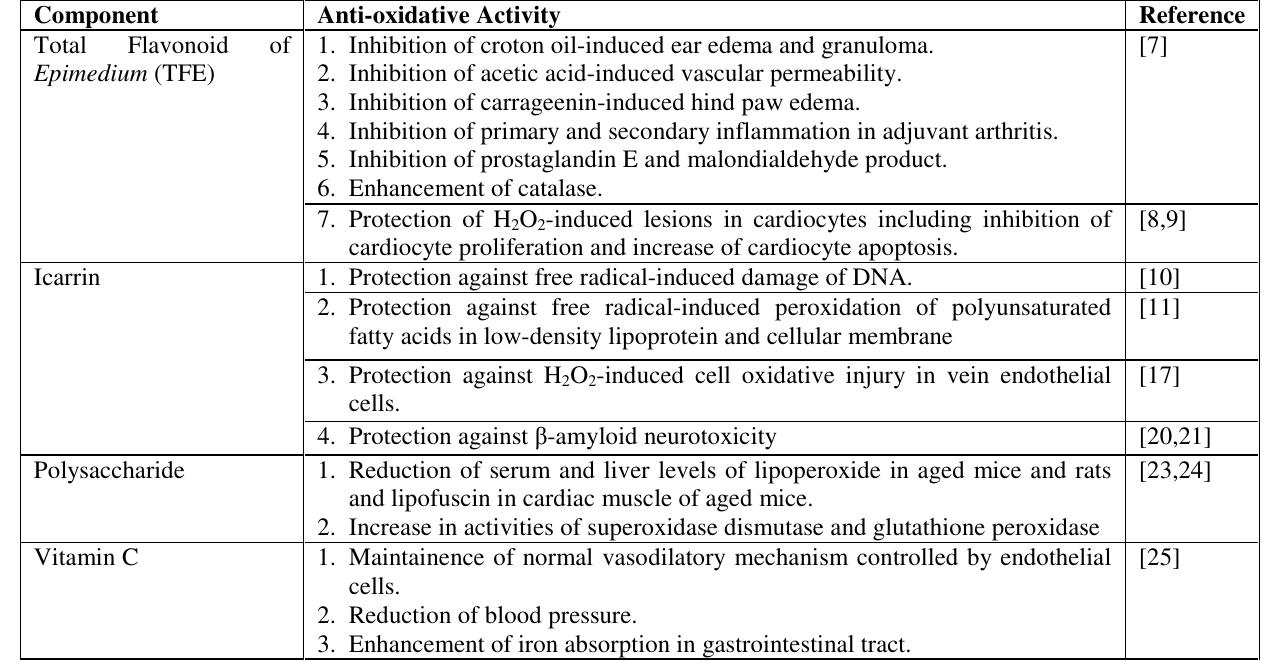
Table 1. Different Components and Activities of Herba